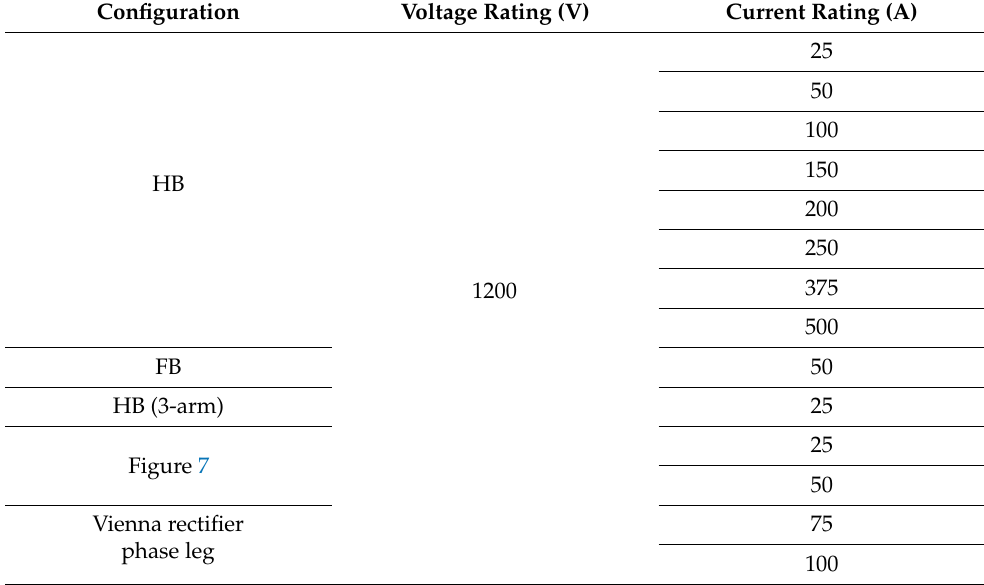
Table 14. Commercial SiC MOSFET modules by Infineon